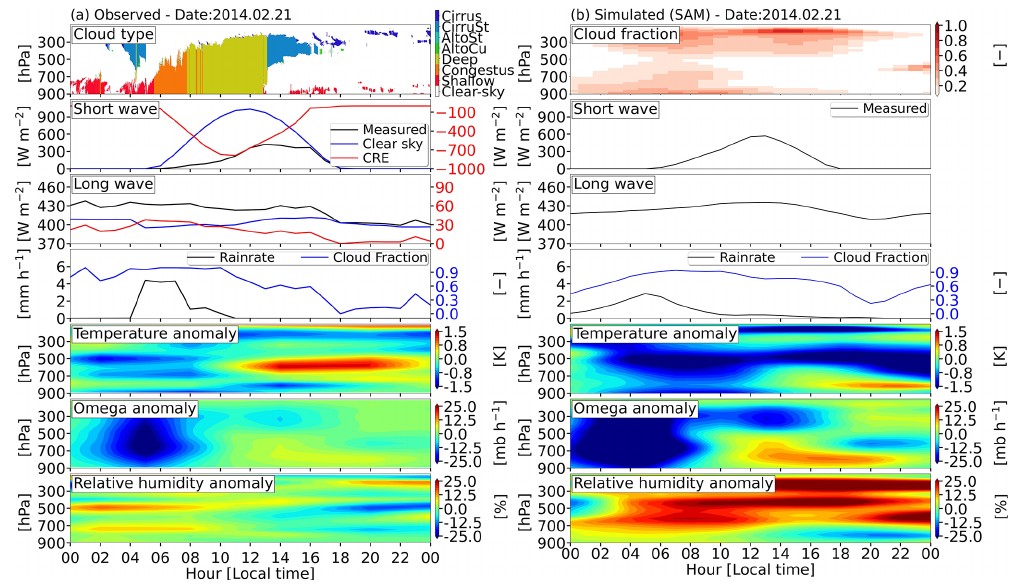
Figure 5. Daily cycle of cloud type, cloud fraction profile, longwave and shortwave radiation fluxes for cloud and clear sky (Wm − 2 ), pre- cipitation rate (mmh − 1 ), integrated cloud fraction and temperature (K), omega (mbh − 1 ), and relative humidity (%) anomaly from 21 Febru- ary 2014 for the (a) observed data and (b) simulated with the SAM